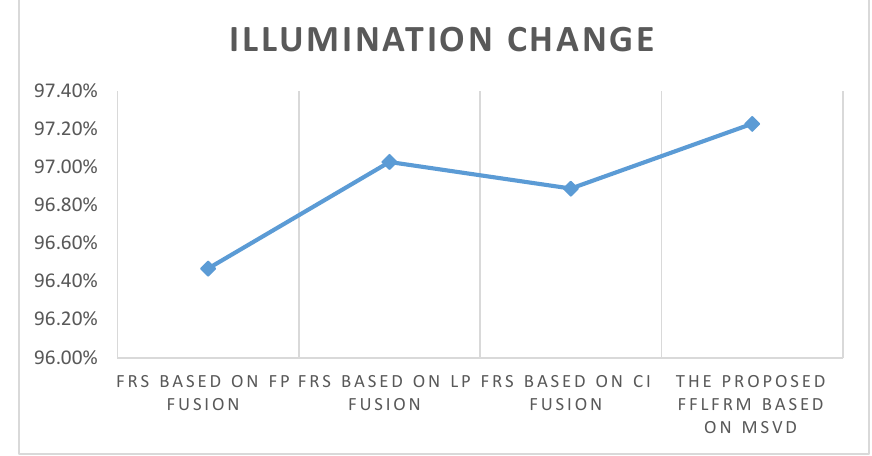
Fig. 5. Recognition accuracies of the four studied FRSs under the condition of illumination